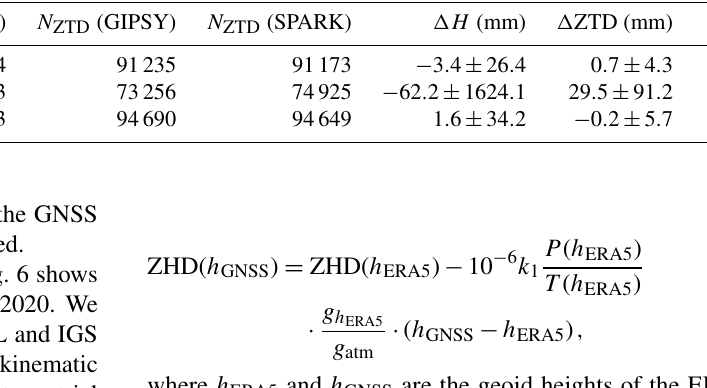
Table 4. Comparisons of GIPSY and SPARK processing results: N sat average number of satellites per epoch; N ZTD the total number of ZTD estimates available after the post-processing data screening, (cid:49)H and (cid:49) ZTD the differences in height and ZTD estimates (SPARK minus GIPSY). Average number of satellites and differences are given as means ± 1 standard